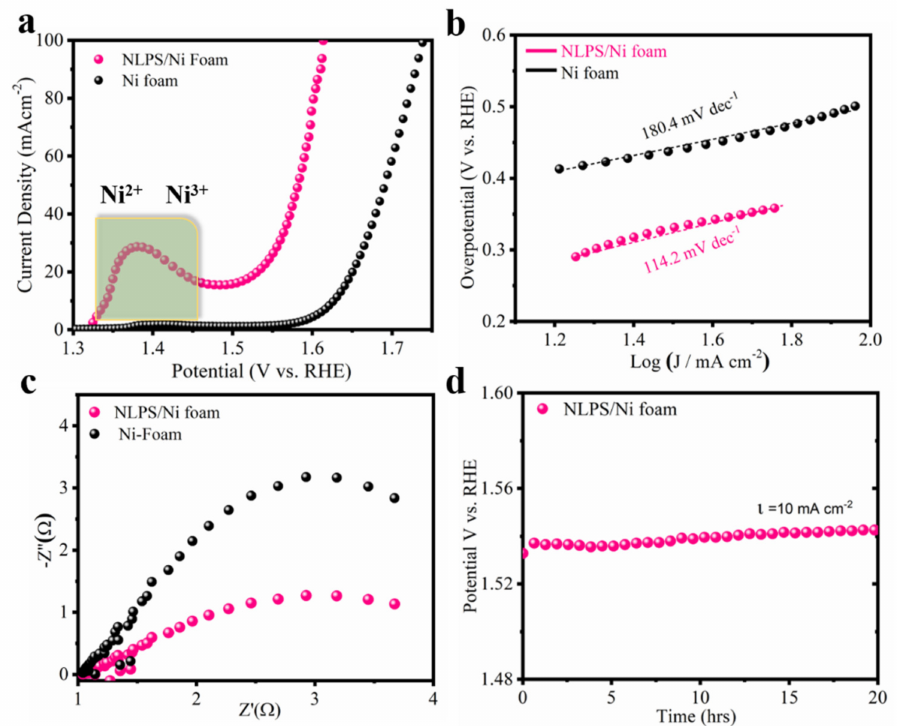
Figure 4. OER electrocatalytic performance in alkaline media. ( a ) Polarization LSV curves and ( b ) Tafel plots of NLPS/Ni foam and Ni foam; ( c ) EIS Nyquist Plot for catalysts; ( d ) durability test of NLPS/Ni foam at 10 mA cm − 2